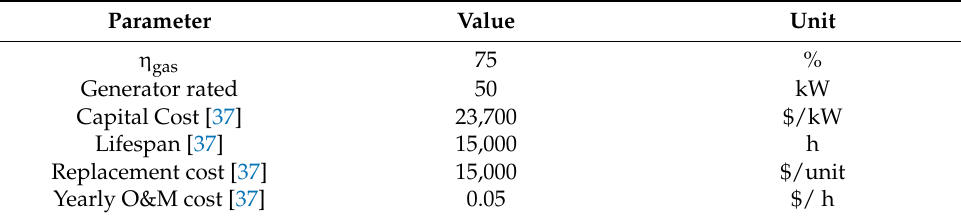
Table 3. The main parameters characteristics of the biomass system.